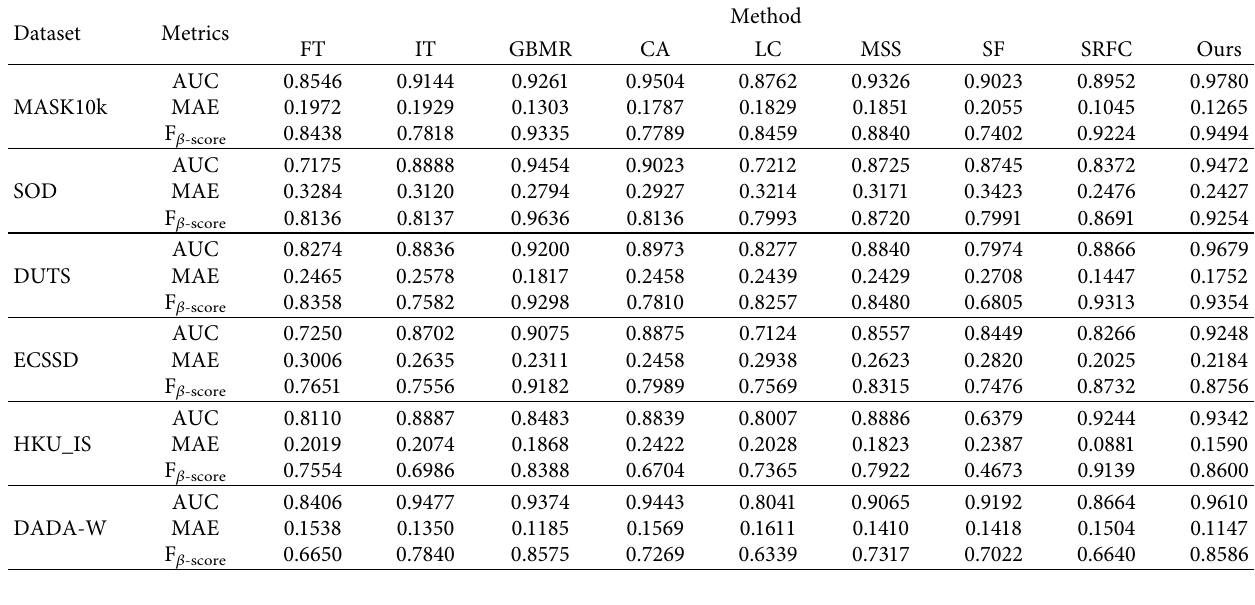
Table 1: Quantitative comparison of different methods over six image